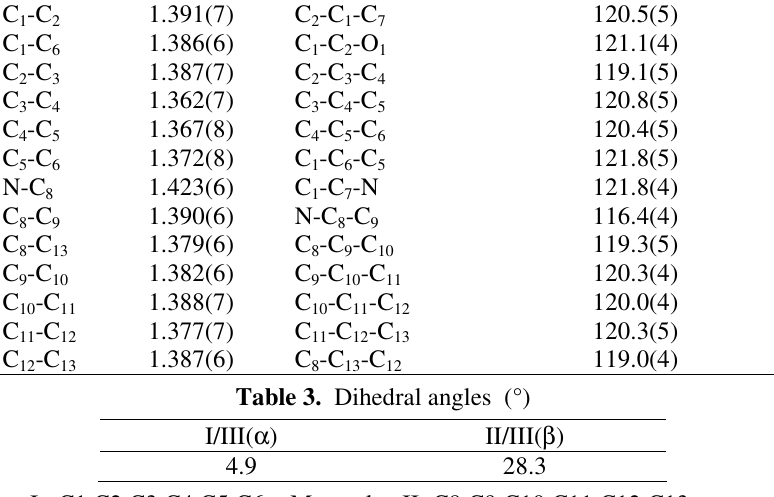
Table 3. Dihedral angles (°)